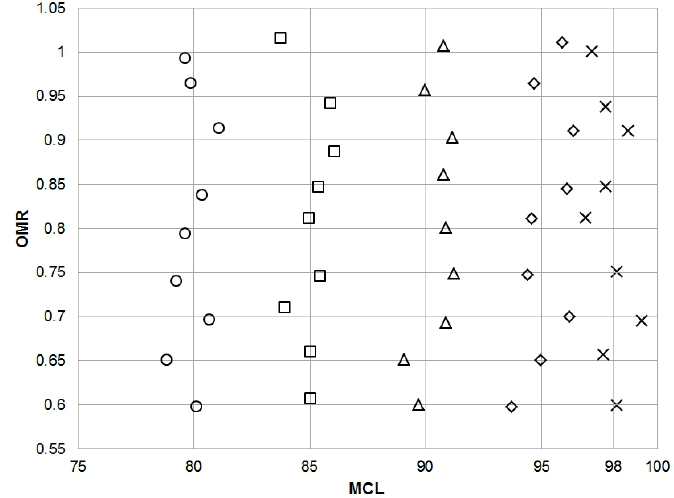
Figure 7. Actual and determined Inlet Molar Ratio (IMR) correlation